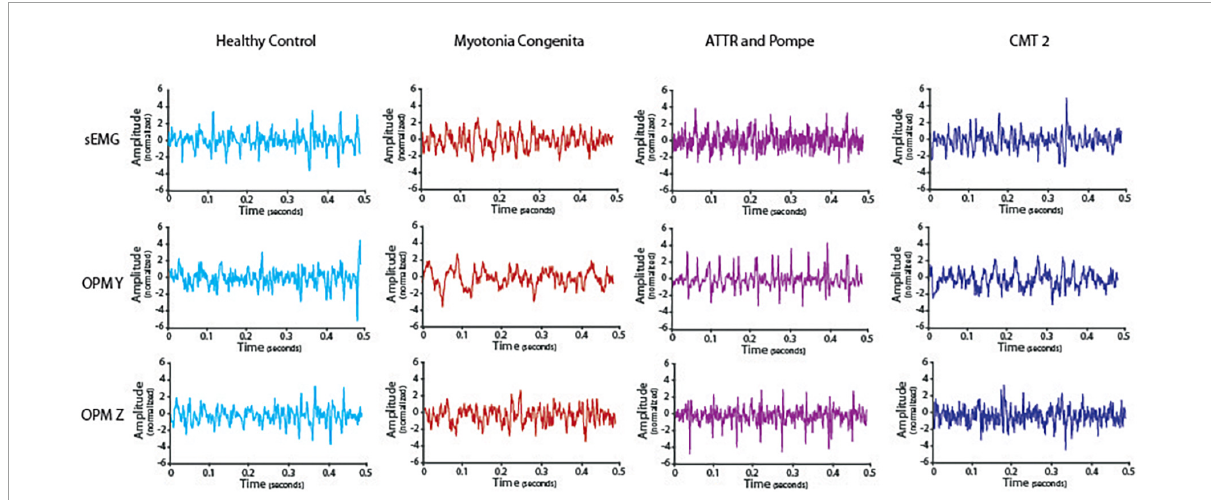
FIGURE2 Timeline of the electromyography (EMG) and optically pumped magnetometer (OPM) signals in one healthy control and all three patients. Depicted is a representative episode of 0.5 s during maximum contraction after preprocessing. ATTR showed reduced interference and high amplitudes, especially in OPM Y but also in OPM Z compared to HC. EMG data from ATTR were still very noisy after